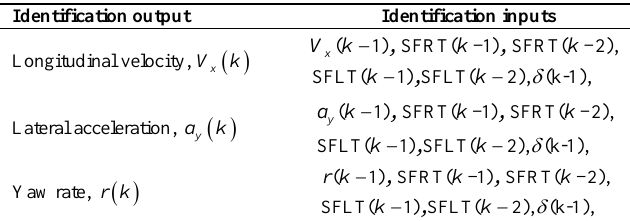
Table 1. Identification inputs and outputs.